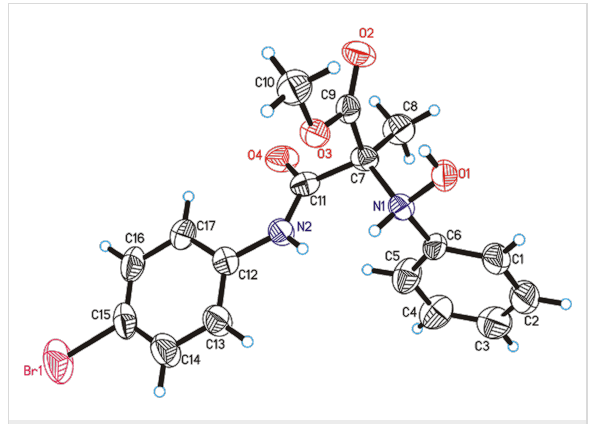
Figure 1: ORTEP diagram drawn with 30% ellipsoid probability for non-H atoms of the crystal structure of chiral compound 4a deter- mined at 293 K. The absolute configuration of C7 is S